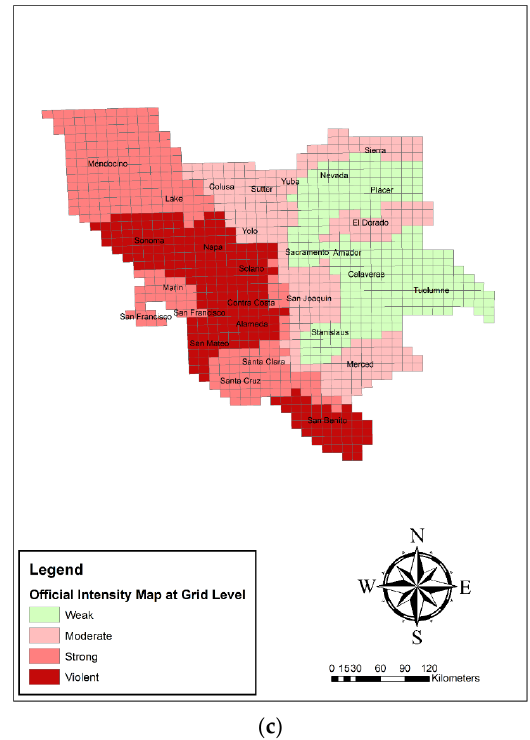
Figure 13. Official damage map at the county ( a ), city ( b ), and 10 by 10 km grids ( c ) scales. • Damage validation at the county scale